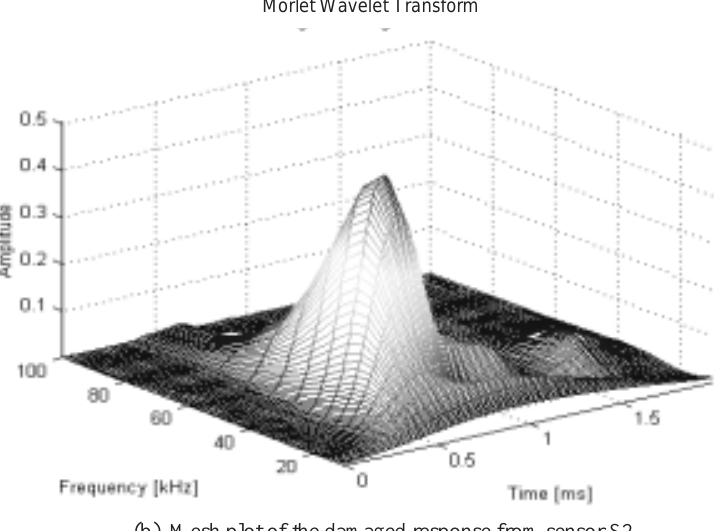
Fig. 21. Wavelet plots of the response of the damage leg of the flexbeam at sensor S2. (a) WTF 5% clipping contour plot using the damaged (sensor S2) and healthy responses (sensor S4) (a) WTF 5% clipping mesh plot using the damaged (sensor S2) and healthy responses (sensor